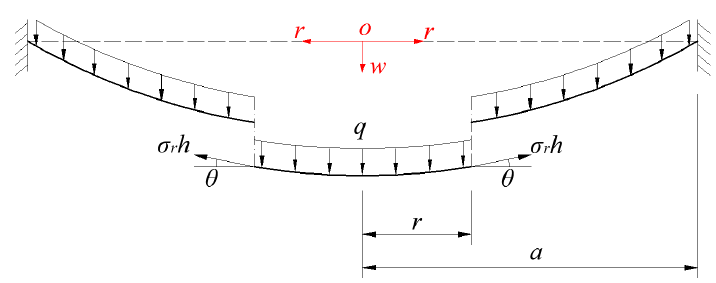
8 of 24 Figure 5. Sketch of the circular membrane under transverse loads q .